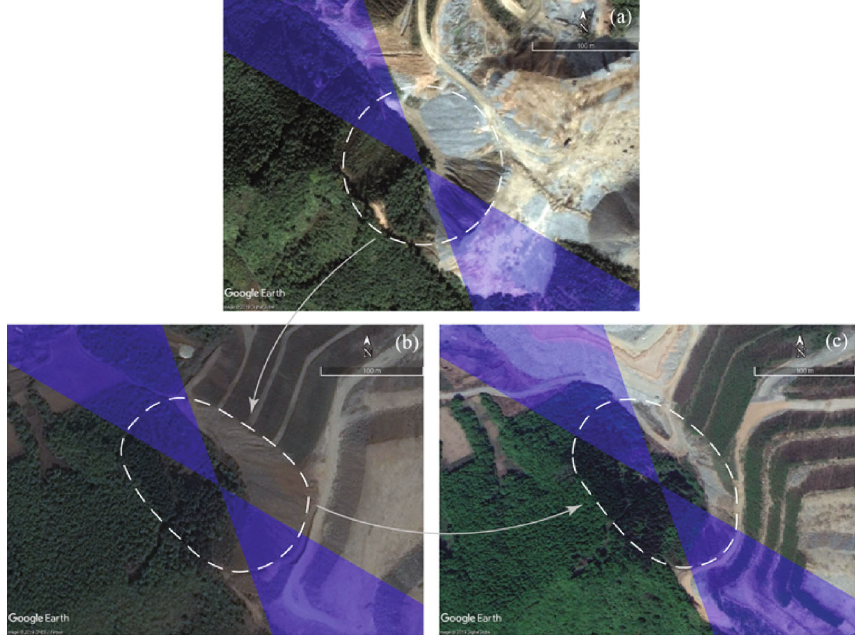
Figure 7: The comparison between the prediction by the proposed model and the observation in Google Earth satellite images for the surface subsidence extension in Xiaowanggou iron mine (41.39 ° N, 123.63 ° E). (a) The circular surface subsidence observed after vertical caving on October 1, 2012. (b) The extended surface subsidence area observed on April 25, 2014. (c) The extended surface subsidence area on May 8, 2017. The blue shadow illustrated indicates direction that the surface subsidence extends to, which is obtained from Figure 6, by comparing the depth of implemented undercut to critical depth of undercut to maintain the surrounding rocks from either rock shear failure or slip failure along the